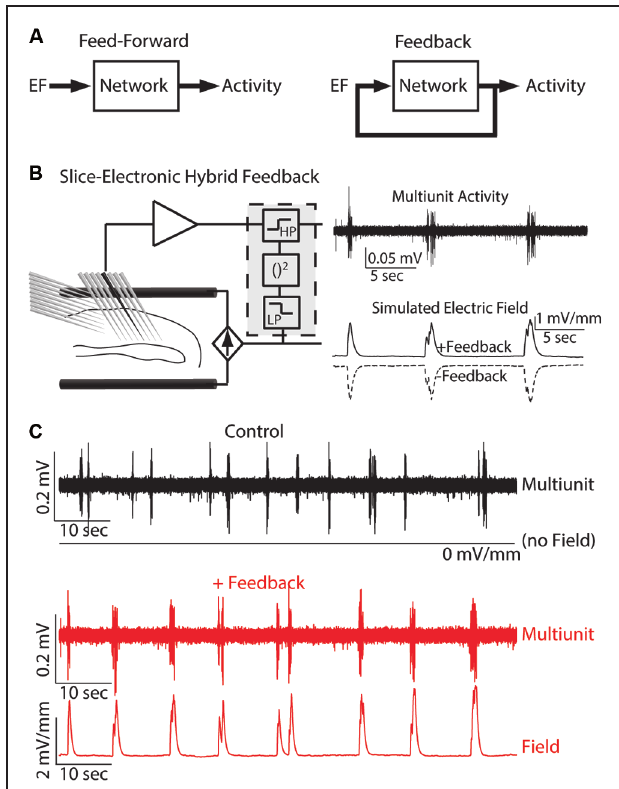
FIGURE 1 | Hybrid biological-electrical system. (A) Control diagrams for both feed-forward and feedback application of EF stimulation. (B) Left: Schematic of the system where EF is applied based on the ongoing neuronal activity. Right: Example multiunit trace of typical endogenous activity (top) and the simulated EF applied for both positive and negative feedback. (C) Multiunit activity and applied EF for both control (top, black) and positive feedback (bottom, red). Reprinted with permission (Frohlich and McCormick,